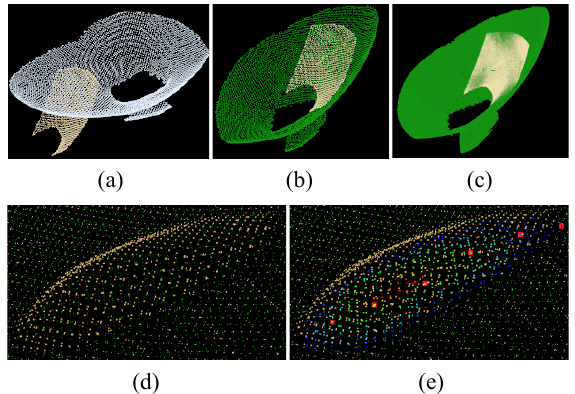
Figure 7. Point cloud and machining path point information in the detection process of the machining target. ( a ) Unregistered point cloud pair; ( b ) Coarse registration; ( c ) Accurate registration; ( d ) Difference point cloud; ( e ) Machining path